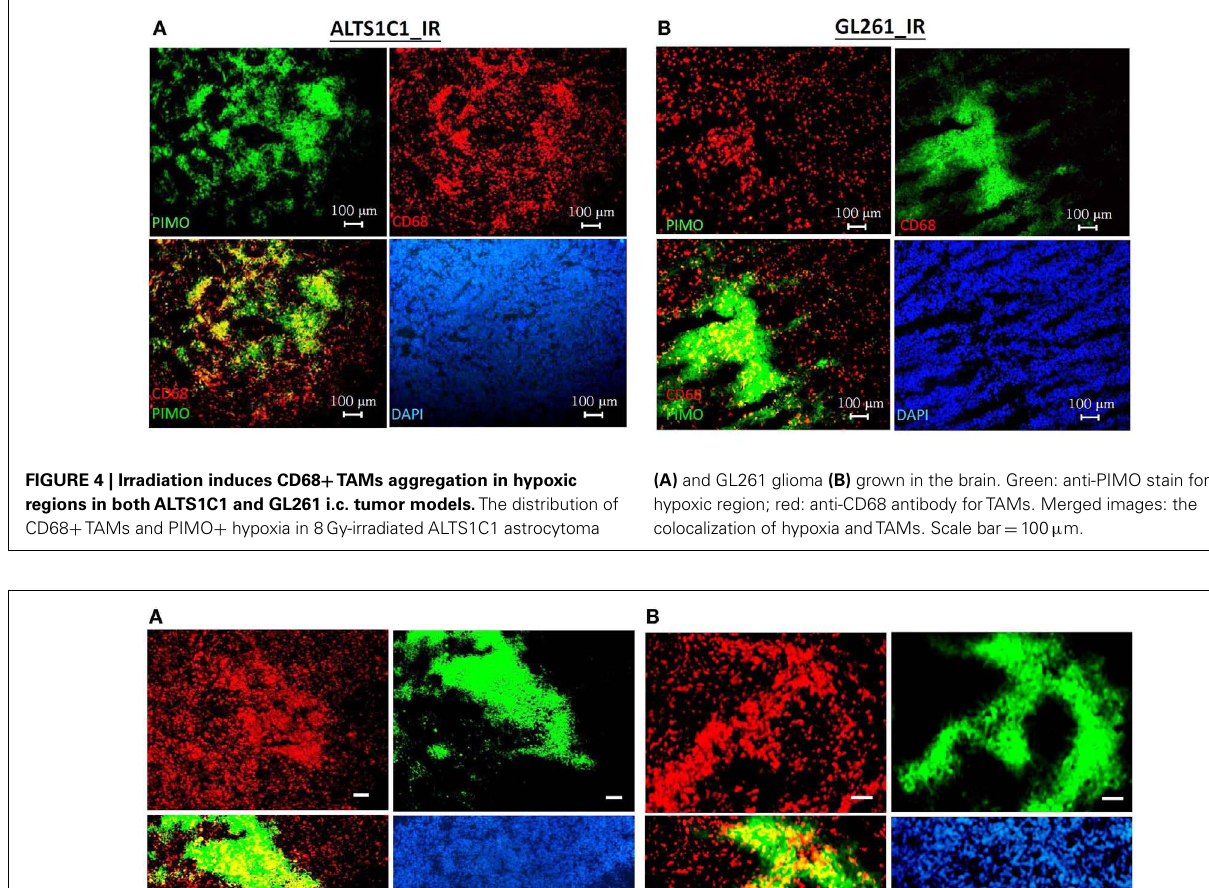
ALTS1C1 astrocytoma grown in the brain (i.c.) (A) or in the thigh (i.m.) (B) . Green: anti-PIMO stain for hypoxic region; red: anti-CD68 antibody forTAMs. Merged images: the colocalization of hypoxia andTAMs. Bar: 100 µ